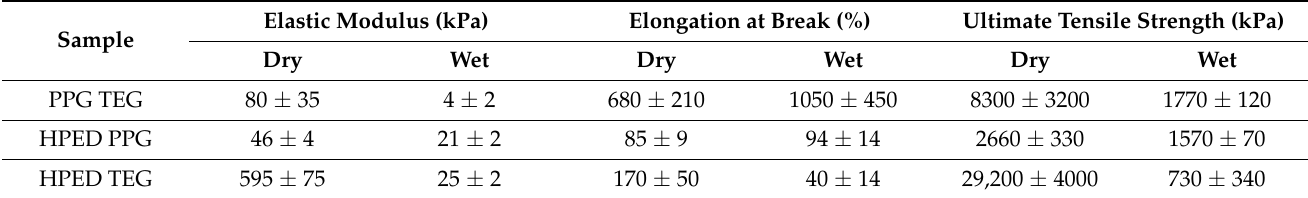
Table 2. Tensile properties of SMP films. Mean ± standard deviation displayed. n = 3.